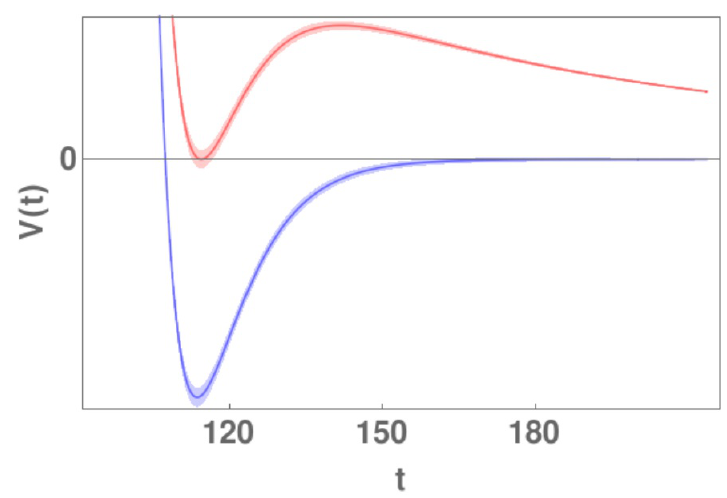
= 0 : 1 and N (cid:24) j W 0 j . 0